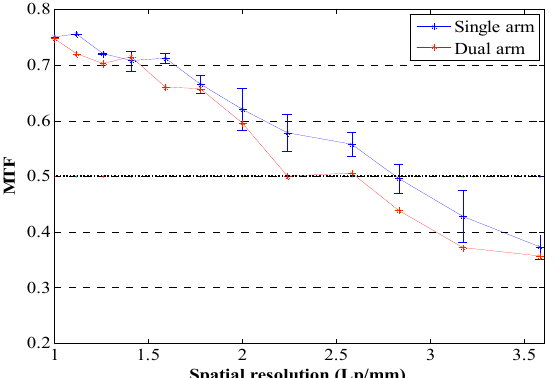
Figure 6. The AOTF-HSI imager modulation transfer function (MTF) plot obtained by imaging USAF-1951 spatial target.